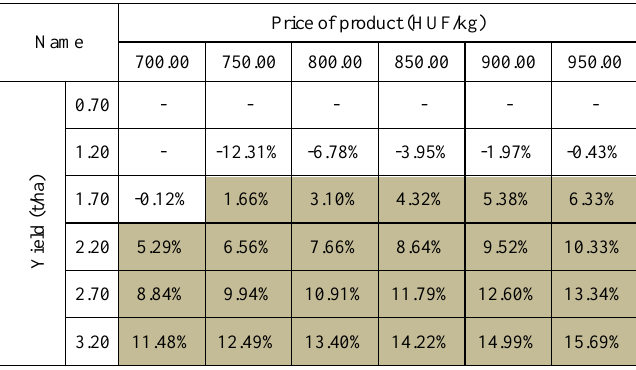
Table 16. Internal rate of return (IRR) of the production of dried walnut as a function of average price and